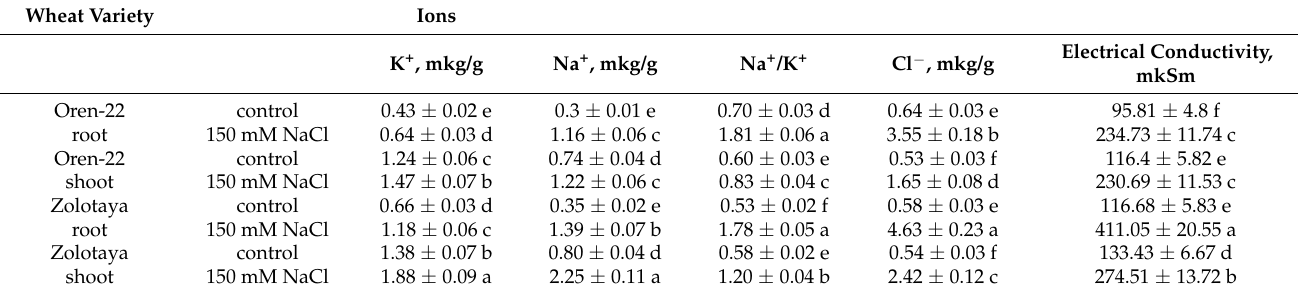
Table 1. Ion content and electrical conductivity in root and shoot of Orenburgskaya 22 and Zolotaya